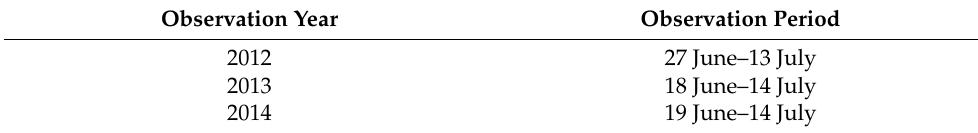
Table 1. Observation period of orographic rainfall during the summer rainy season.